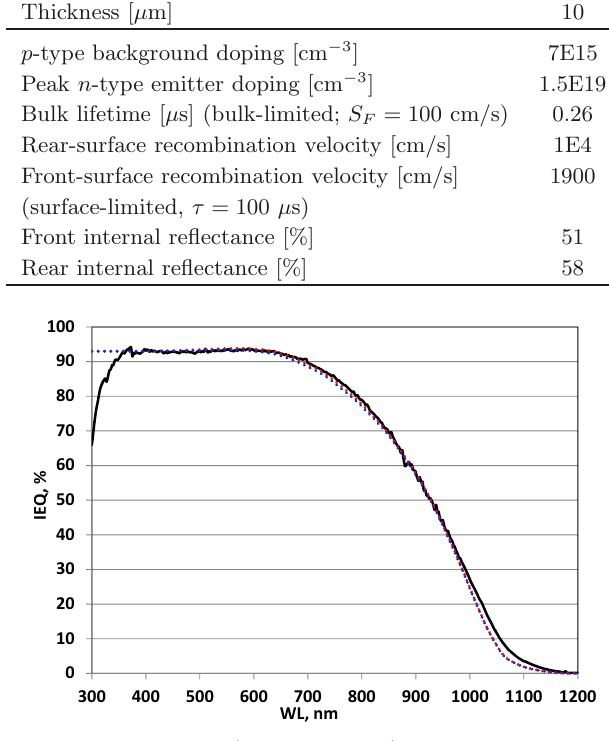
Fig. 6. Experimental (black-solid line) IQE curve and front- surface (blue-dotted line) and bulk recombination (red-dotted line) limited model fits of the cell on the oxide